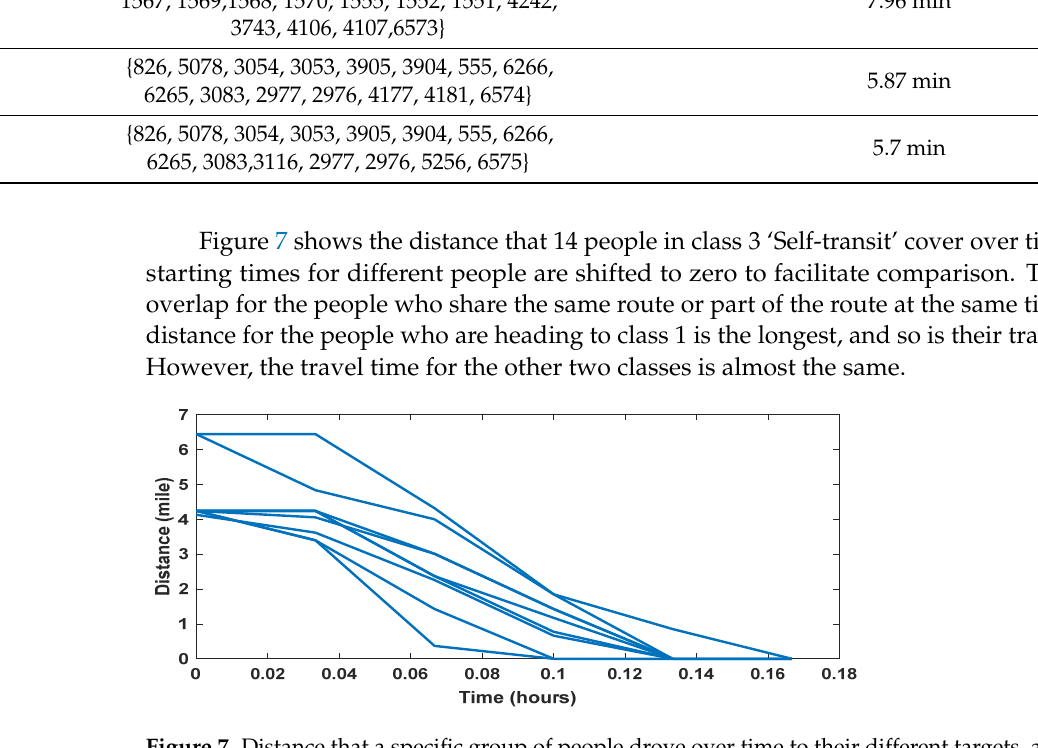
Figure 7. Distance that a specific group of people drove over time to their different targets, aligned to the same departure